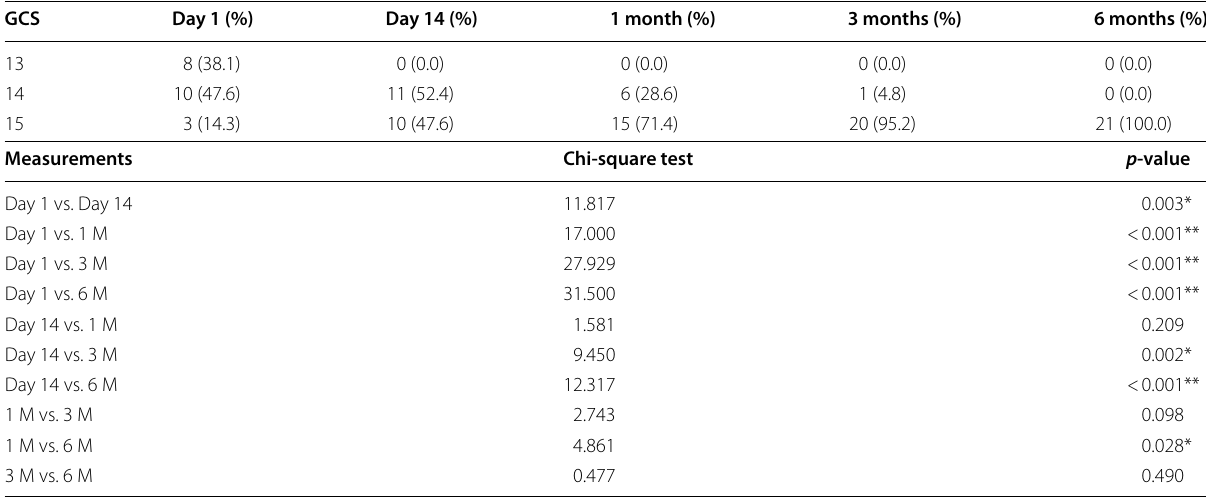
21) throughout study duration. B Comparison between =